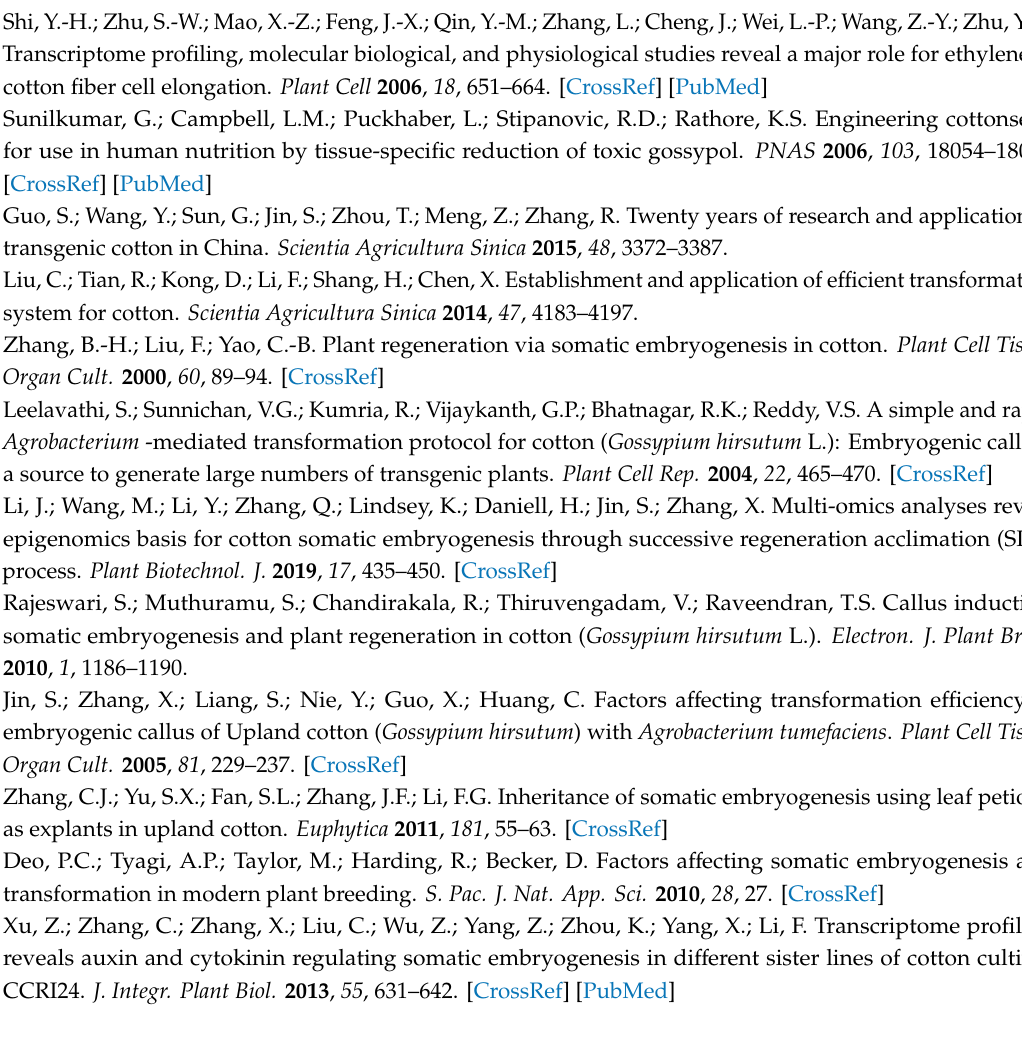
Figure S1. Multiple sequence alignment of ARF proteins from Arabidopsis and upland cotton showed conserved residues or motifs. Figure S2. Multiple sequence alignment of Aux / IAA proteins from Arabidopsis and upland cotton showed conserved residues or motifs. Figure S3. Multiple sequence alignment of GH3 proteins from Arabidopsis and upland cotton showed conserved residues or motifs. Figure S4. Multiple sequence alignment of SAUR proteins from Arabidopsis and upland cotton showed conserved residues or motifs. Figure S5. Domain and exon–intron organization structure of identified ARF ( a ), Aux / IAA ( b ), GH3 ( c ), SAUR ( d ) family gene members in Arabidopsis and upland cotton. Figure S6. Co-expression network showing the tight correlationship among the four auxin early response families. Table S1. The summary of expression of auxin early response genes during the transformation from NEC to EC. Table S2. Primers used for qRT-PCR validation of expression pattern of auxin early response